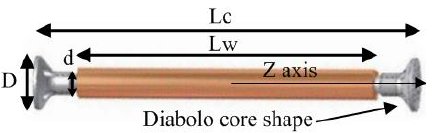
Figure 1. Diagram of an induction sensor with a diabolo core